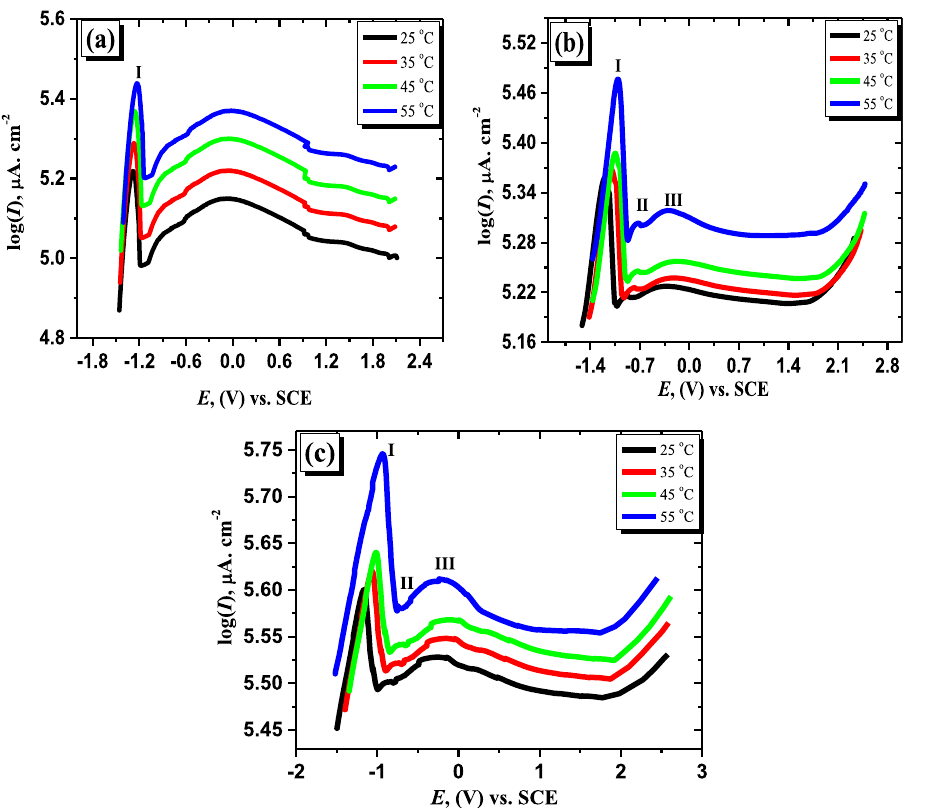
Figure 2. The characteristics of anodic potentiodynamic polarization in the alkaline solution for Zn ( a ), alloy I ( b ), and alloy II ( c ) at various